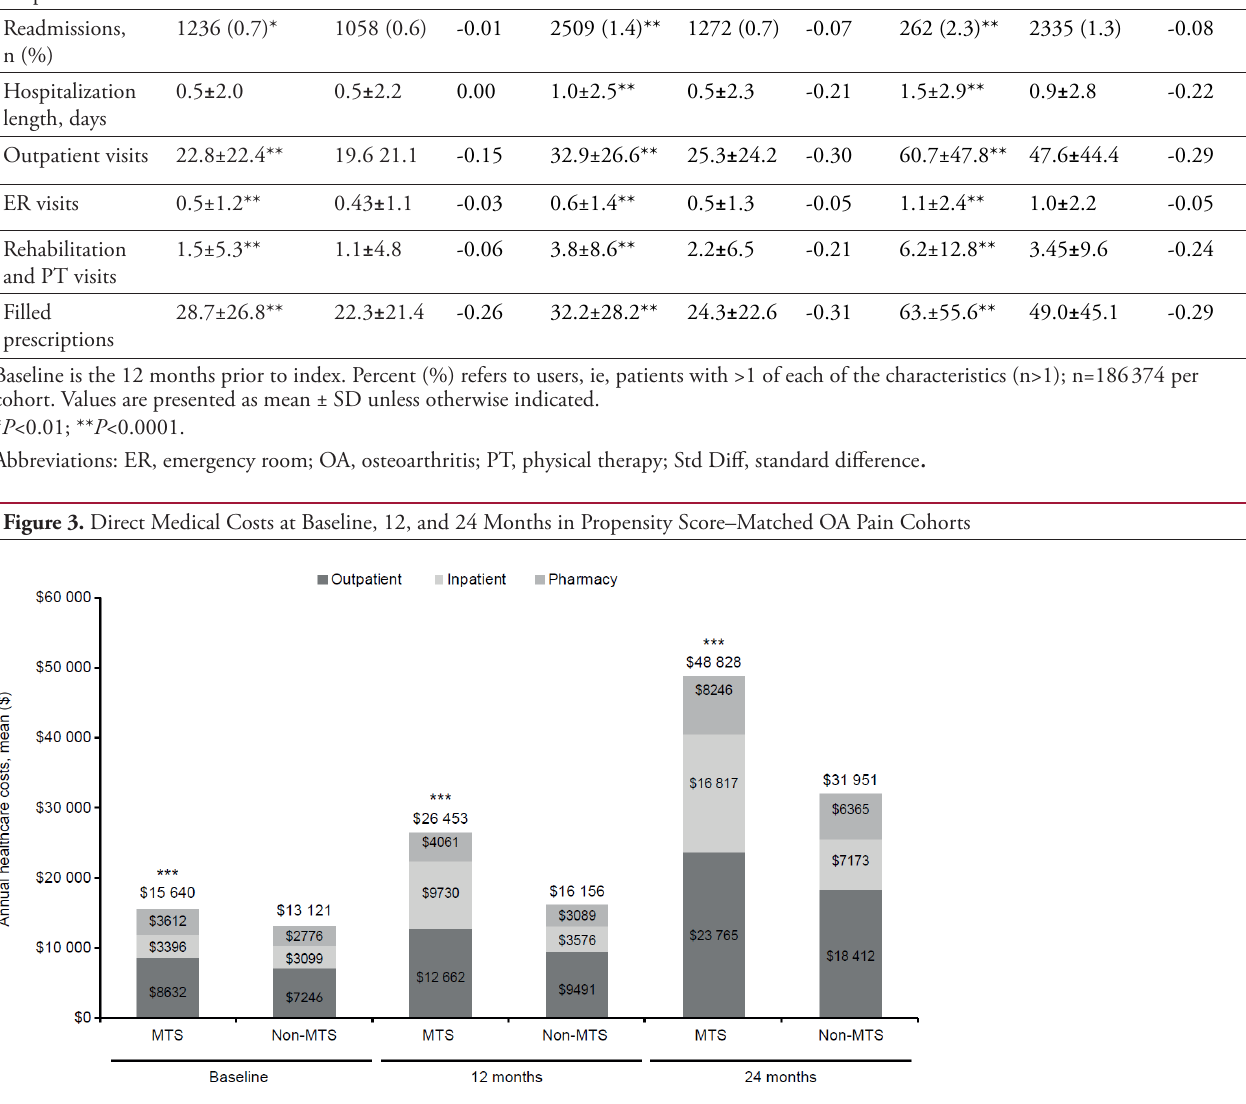
Direct medical costs at baseline, 12, and 24 months in the propensity score-matched OA pain cohorts (n=186 374 per cohort) The number on top of each bar represents the total healthcare costs, which is a sum of inpatient, outpatient, and pharmacy costs. *** P